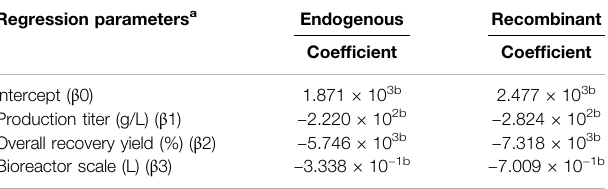
TABLE 4 | Results for linear multiple